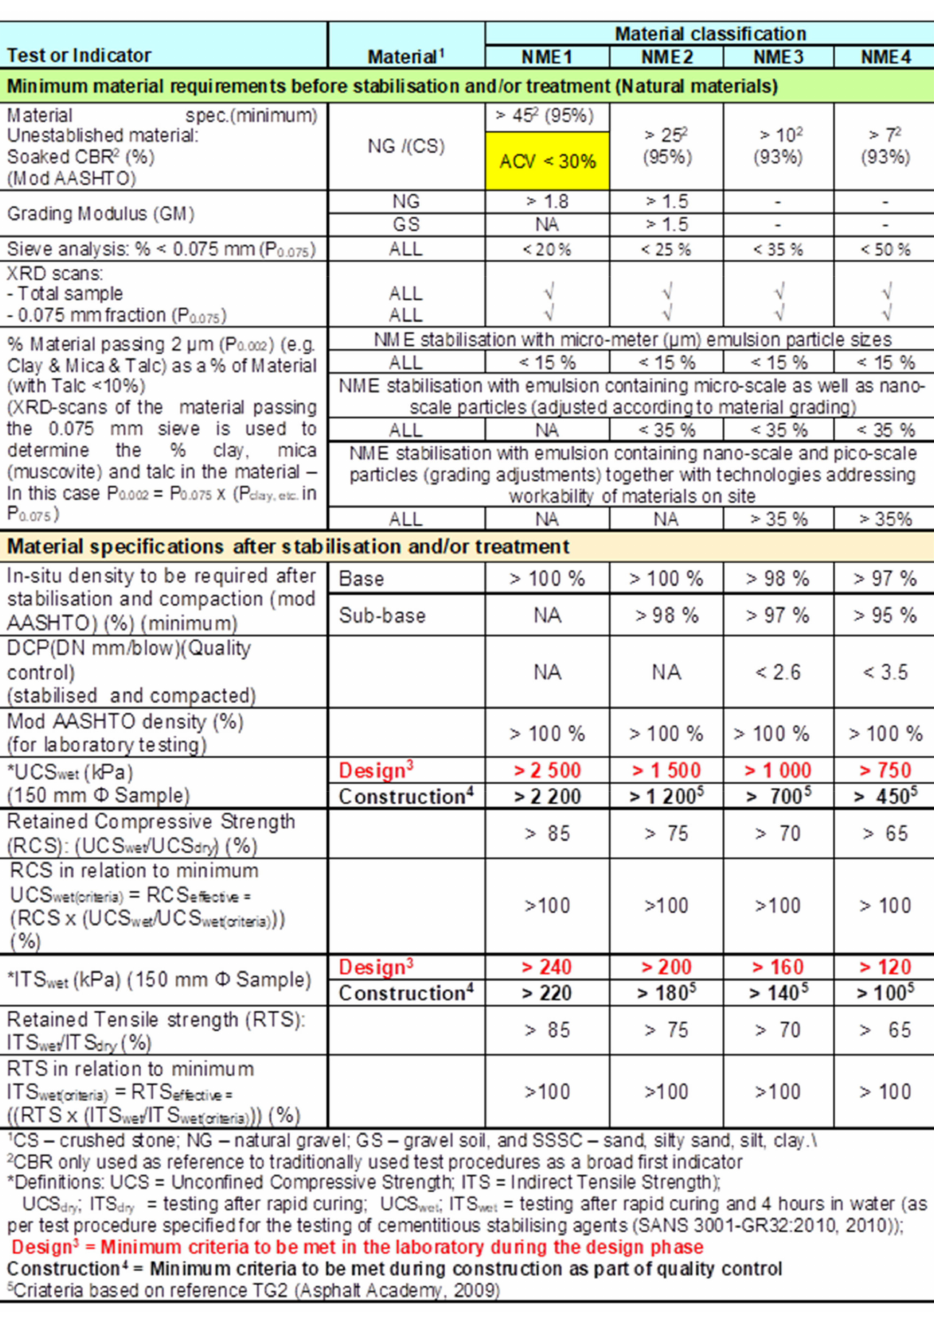
Figure 25. Minimum recommended standard specifications for New-age (Nano) Modified (NME) stabilised materials, addressing four different classifications in terms of engineering